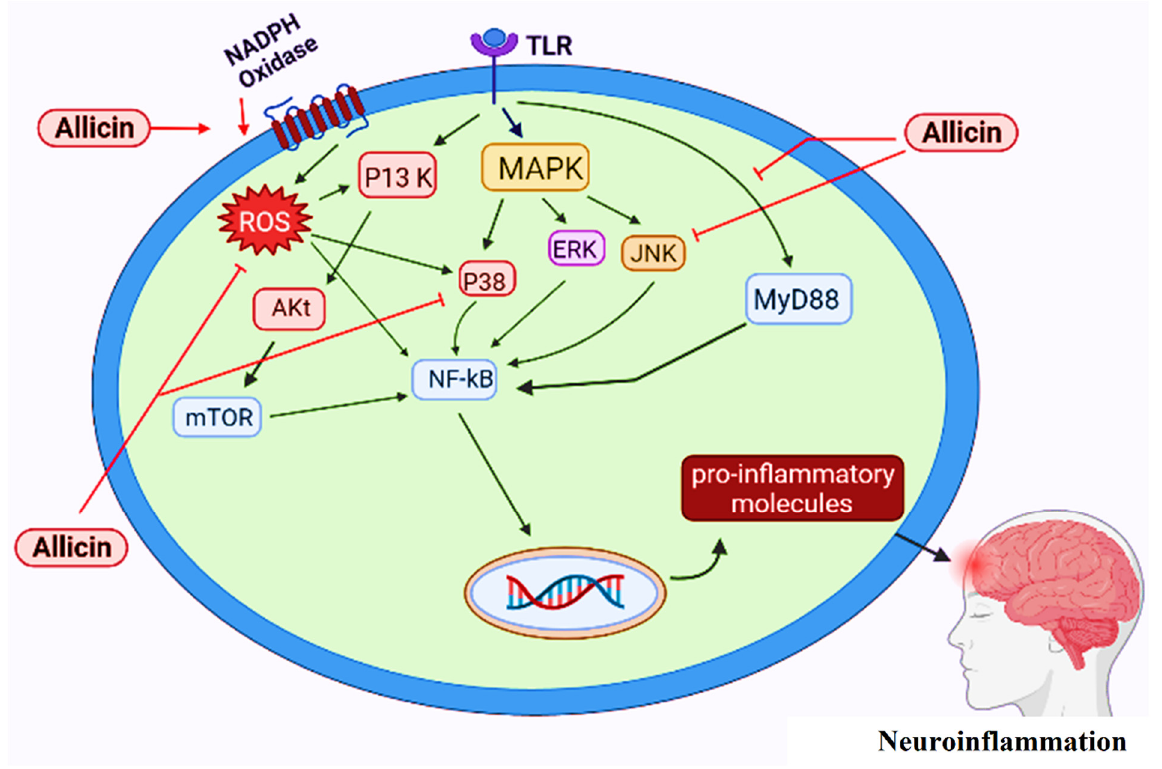
Figure 7. Proposed protective role of allicin against neuroinflammation based on recent literature.